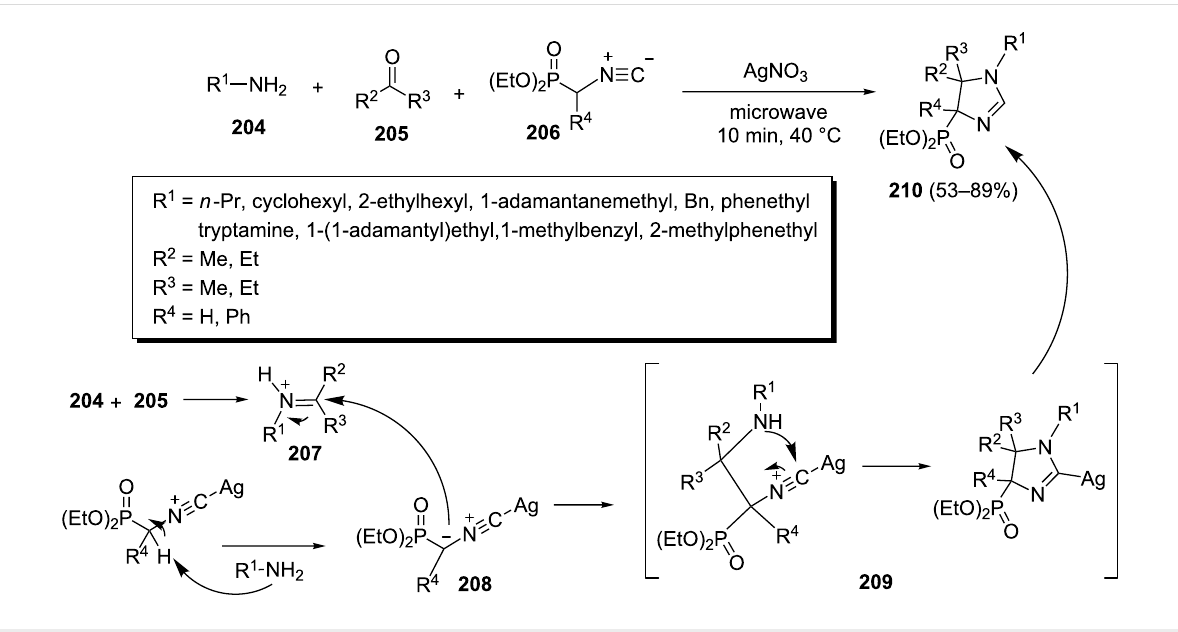
Scheme 43: Silver-catalyzed three-component synthesis of